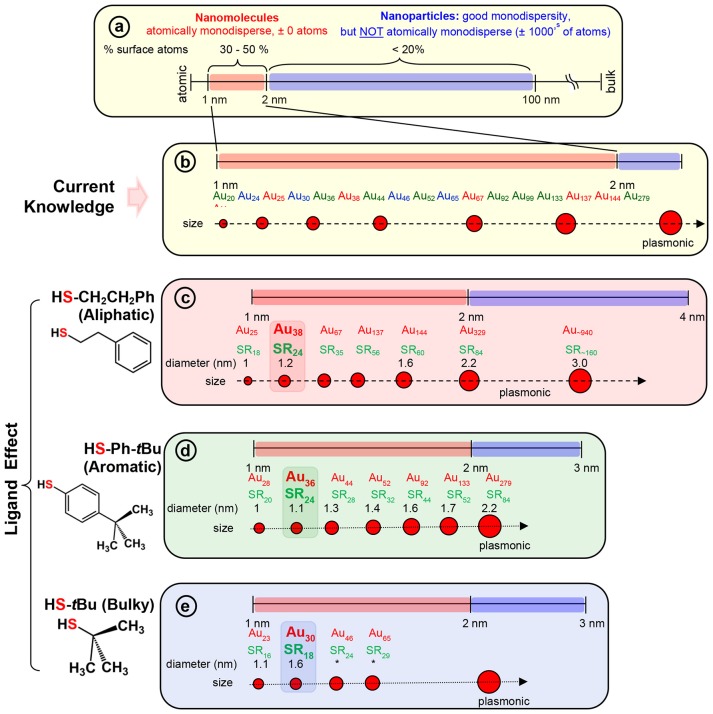
(a) The scheme shows the 1–100 nm size regime with atomically precise NMs in the 1–2 nm region, and NPs in the 2–100 nm regime (where, very good monodispersity in size has been achieved, but atomic composition can vary by ± 1000's of atoms). Examples of widely investigated NMs with three classes of thiolate ligand are given under each series. (b) Widely investigated thiolate protected gold NM systems belonging to each series. NMs with; (c) aliphatic and aliphatic-like ligand, HSCH2CH2Ph, (d) aromatic ligand, HSPh-tBu, and (e) bulky ligand, HS-tBu are illustrated under each scheme. The thermodynamically most stable NM in the aliphatic, aromatic, and bulky series namely, Au38(SCH2CH2Ph)24, Au36(SPh-tBu)24, and Au30(S-tBu)18 NMs respectively, are highlighted. Asterix indicates unknown diameter of the NM due to lack of crystal structure.